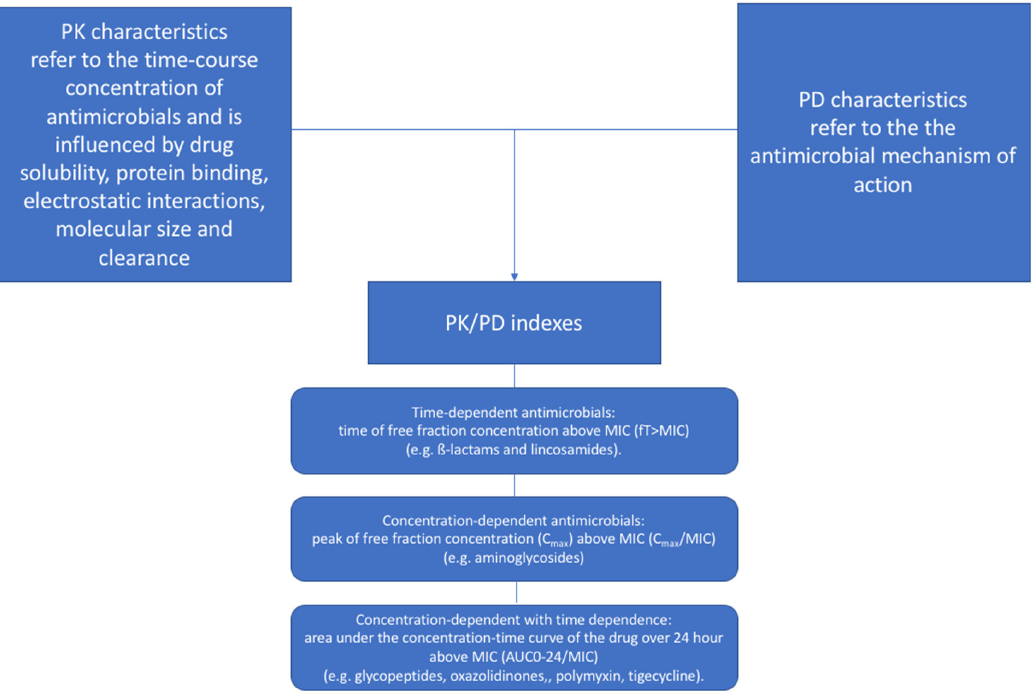
Figure 1. PK/PD indexes. Abbreviations: AUC, area under curve; MIC, minimum inhibitory concentration; PD, pharmacodynamic; PK,